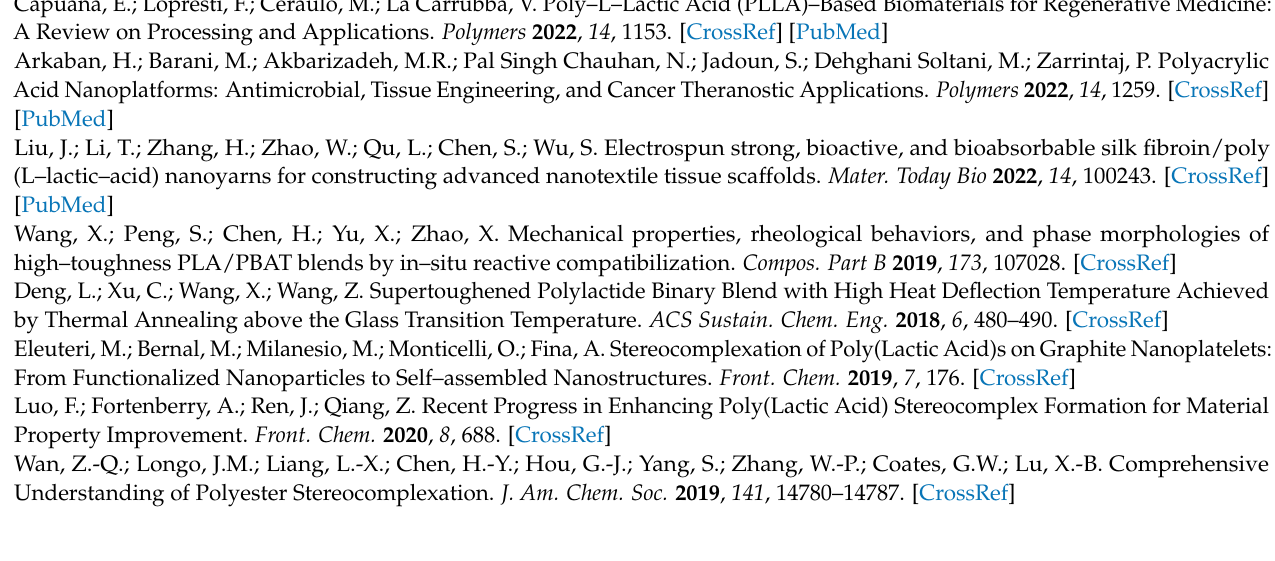
Figure S2: ATR–FTIR spectra of the PLLA and PLLA/SC, Figure S3: Cell viability of HCAEC in 12 mM L–Lac with surface–modified MH at a concentration of 10 phr for 24